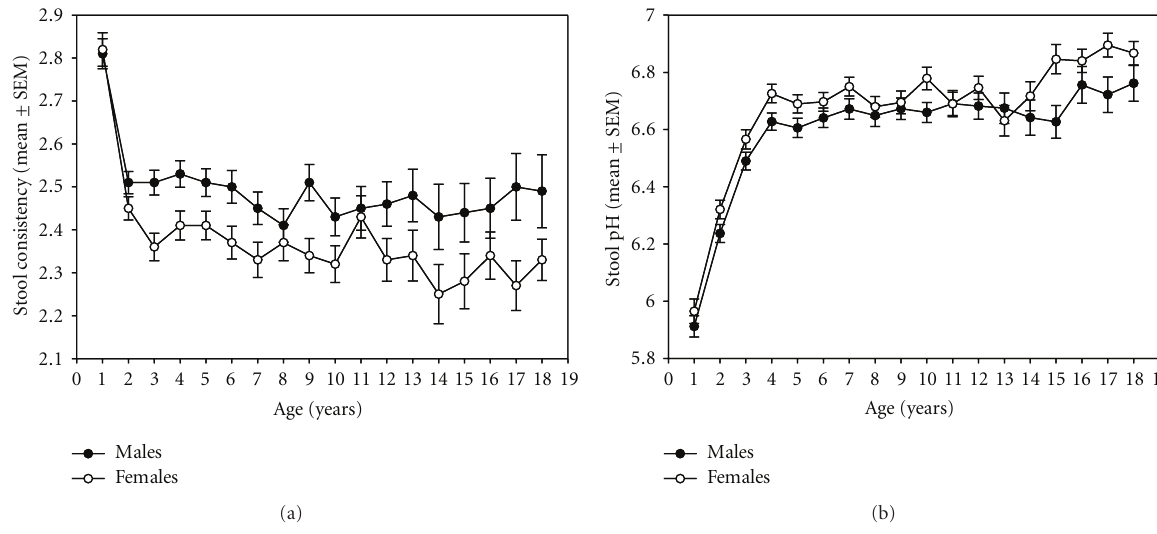
Figure 6: Stool consistency (mean ± SEM) (a) (1 = solid, 5 = liquid) and stool pH (mean ± SEM) (b) by gender and age (years).